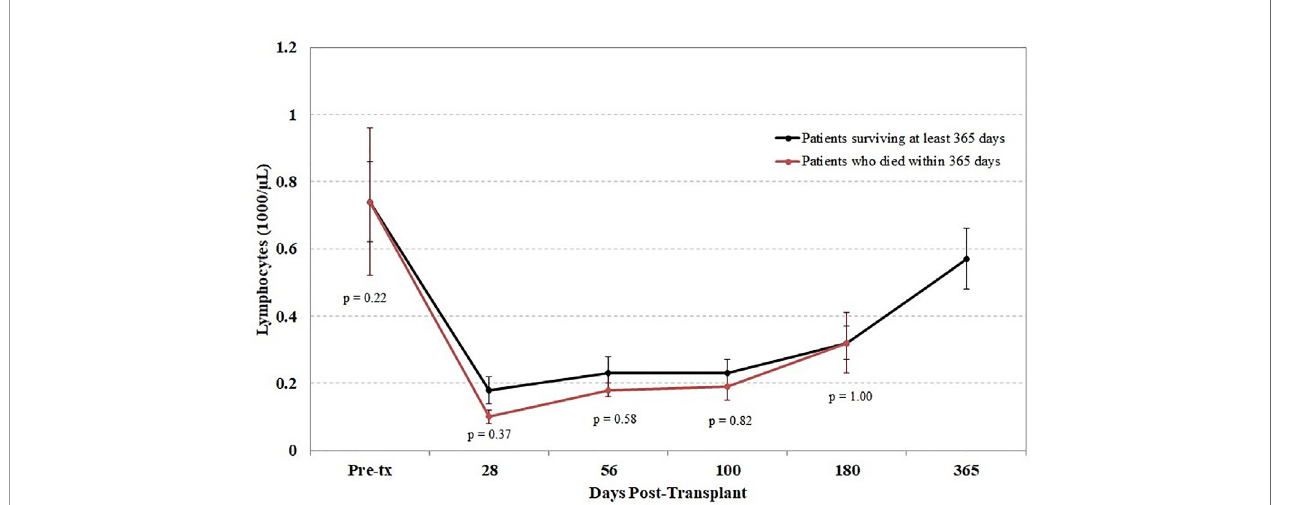
FIGURE 5 | Impact of lymphocyte counts on survival. Peripheral blood samples were taken from each cord blood transplantation (CBT) patient before transplant and fi ve times after transplant. Patients are divided into those who survived through 1-year posttransplant (black) and patients who died within 1 year (red). At each of six time-points (0, 28, 56, 100, 180, 365 days posttransplant), we report the mean and the mean standard error of lymphocyte counts for each group of patients. No signi fi cant differences were seen at any time point between the two groups. For the six time-points in order, N = 14, 16, 17, 17, 14, 17 for patients who survived through day 365; N = 15, 11, 10, 10, 6 for patients who died before day 365. At each time-point, all surviving patients with TCR sequencing data are